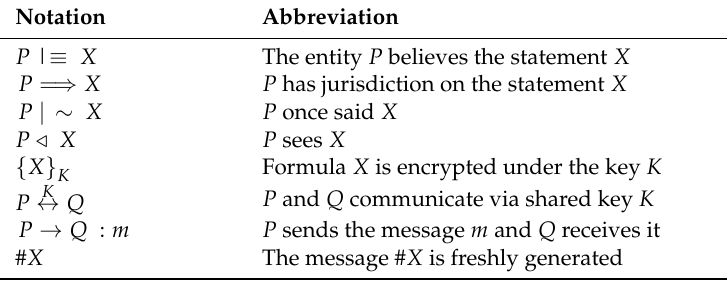
Table 2. BAN (Burrows-Abadi-Needham) logic notations and respective abbreviations.